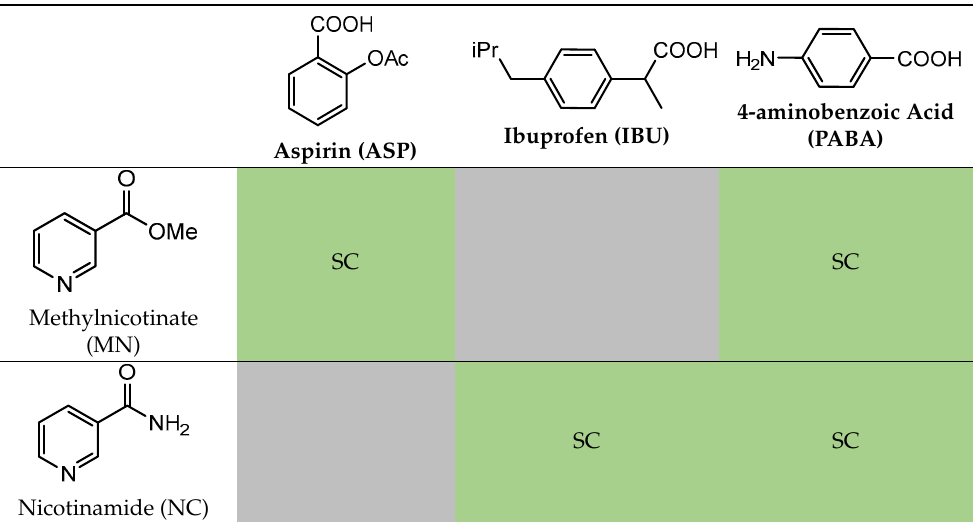
Table 1. Complexation screening results. Green stands for the successful mechanochemical combi- nation; grey means an oil-like product was obtained. SC means the combination was confirmed by structural analysis of a single crystal (SC).